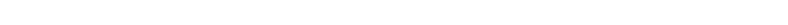
Table 1 Descriptions of core components of